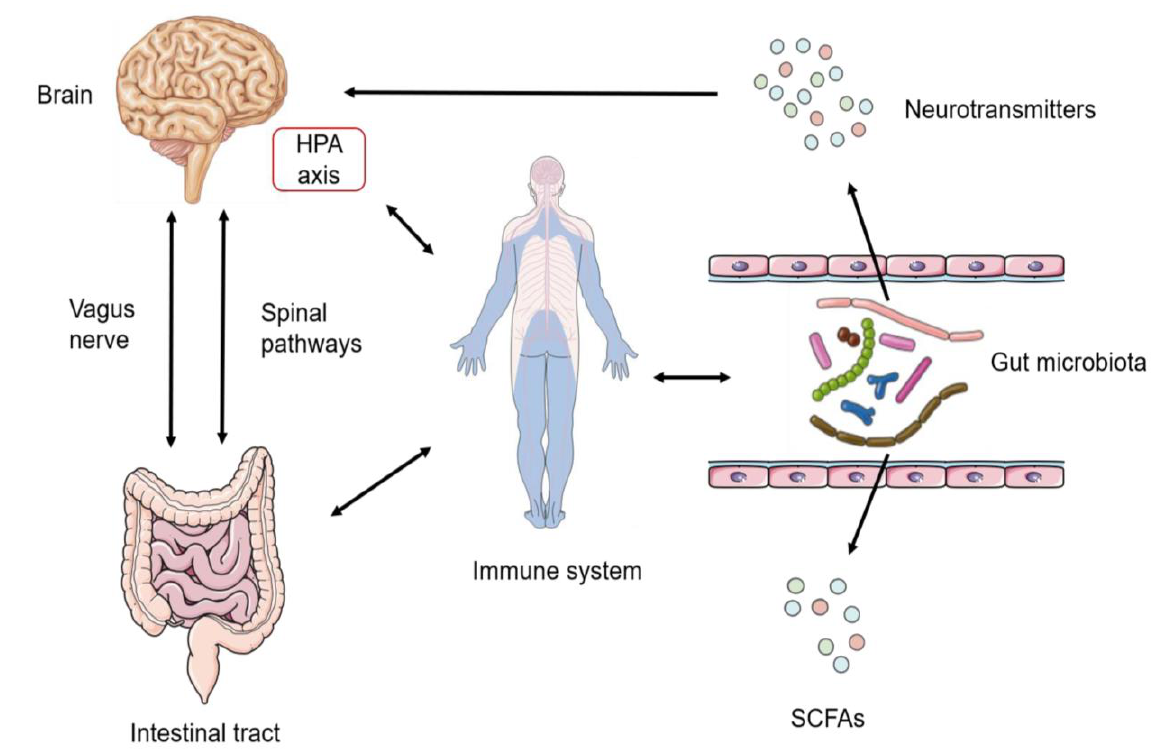
FIGURE 2: Routes of communication in the gut-brain-axis (GBA). The Gut microbiota is one of the key regulators of gut-brain function. Communication within the occurs through these three ways: the immune pathway, the neuroendocrine pathway (neurotransmitters), and the vagus pathway, involving microbial metabolites such as SCFAs. LAB maintain homeostasis and affect host behaviors via the microbiota – gut – brain axis. HPA, hypothalamic – pituitary – adrenal axis, is central to homeostasis, stress responses, energy metabolism, and neuropsychi- atric